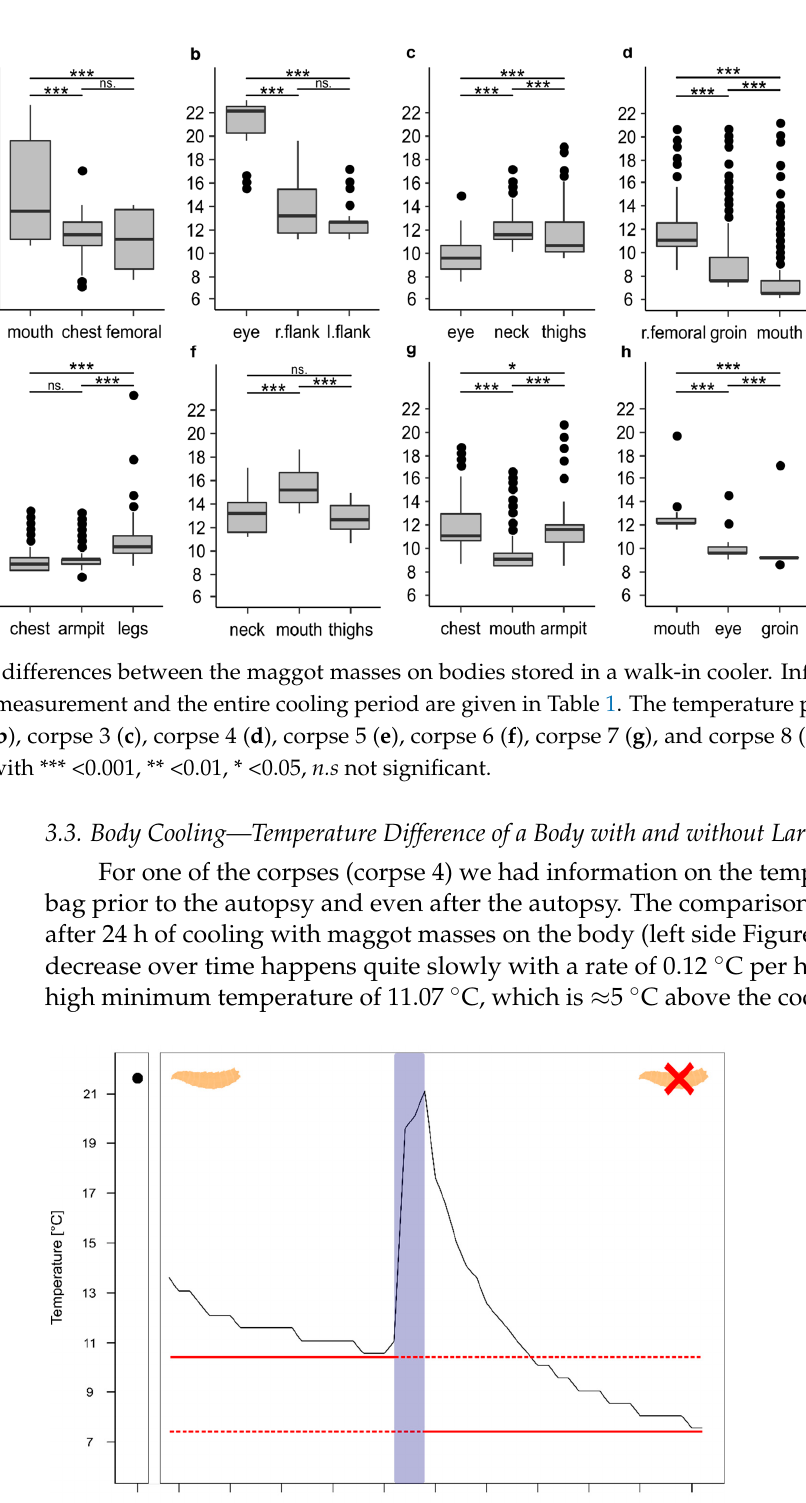
Figure 1. Temperature profiles of bodies heavily infested with insect larvae stored in a walk-in cooler in the Institute of Legal Medicine Frankfurt from May until August 2017. Information on the exact position of the iButton on the body, the period of temperature measurement and the entire cooling period are given in Table 1. The temperature profiles belong to corpse 1 ( a ), corpse